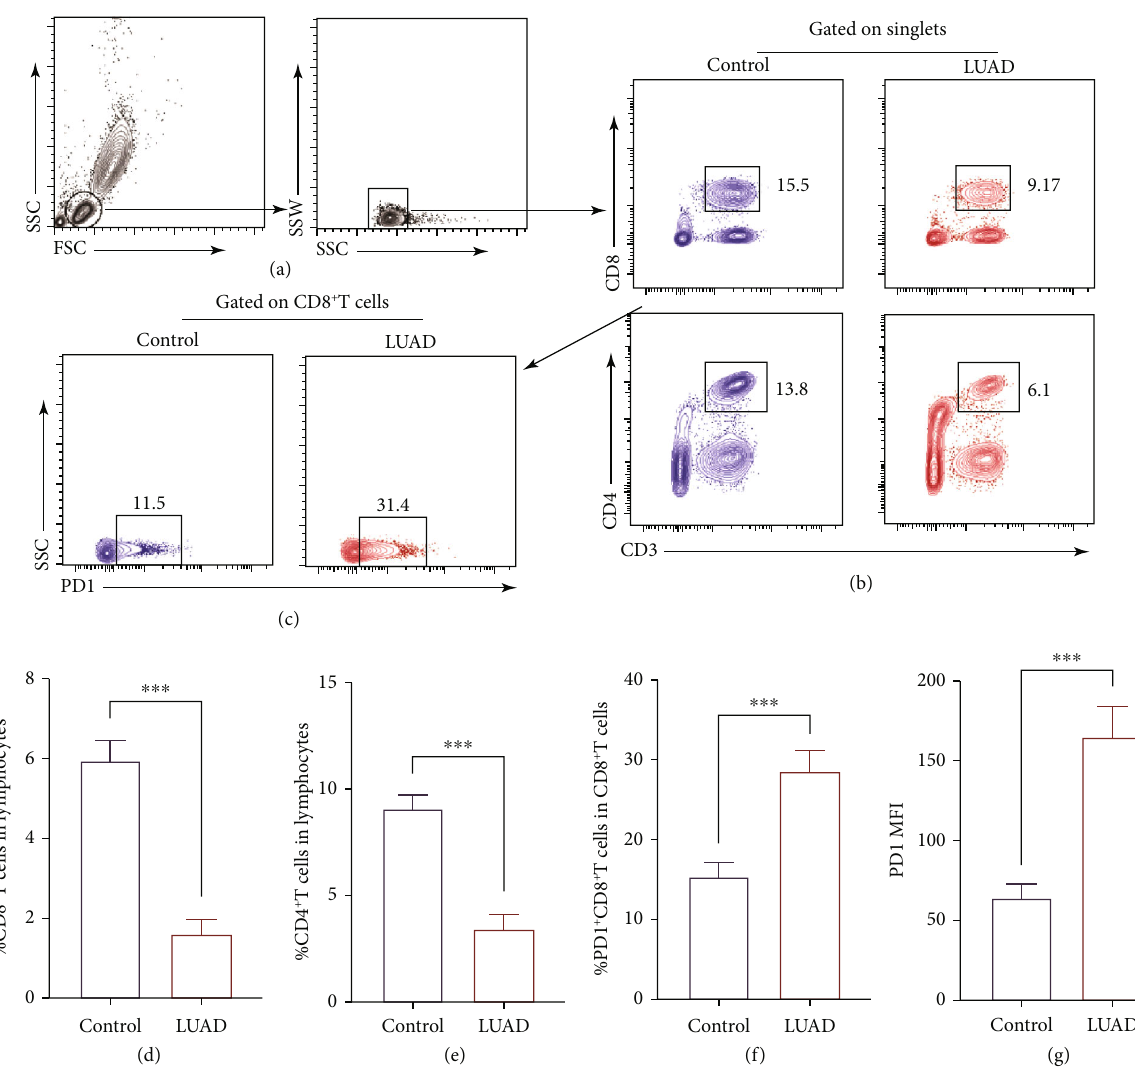
Figure 4: LUAD patients showed immunosuppression and exhaustion of T cells compared with healthy controls. Gating of CD4 + T/CD8 + T cells ((a) and (b) and PD1 in CD8 + T cells (c) from patients and healthy controls. Frequency of CD8 + T cells (d) and CD4 + T cells (e) of blood samples from patients and healthy controls. (f) Frequency of PD1 + CD8 + T cells of blood samples from patients and healthy controls. (g) The MFI of PD1 in CD8 + T cells. Data shown were represented as mean ± SD (all samples were measured in triplicate). ∗∗∗ P < 0 : 001